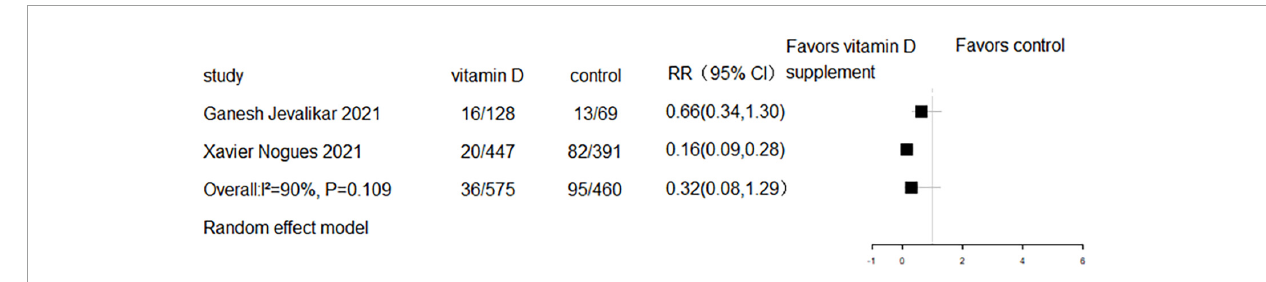
FIGURE7 Forest plot of cohort studies for vitamin D supplementation on ICU admission.